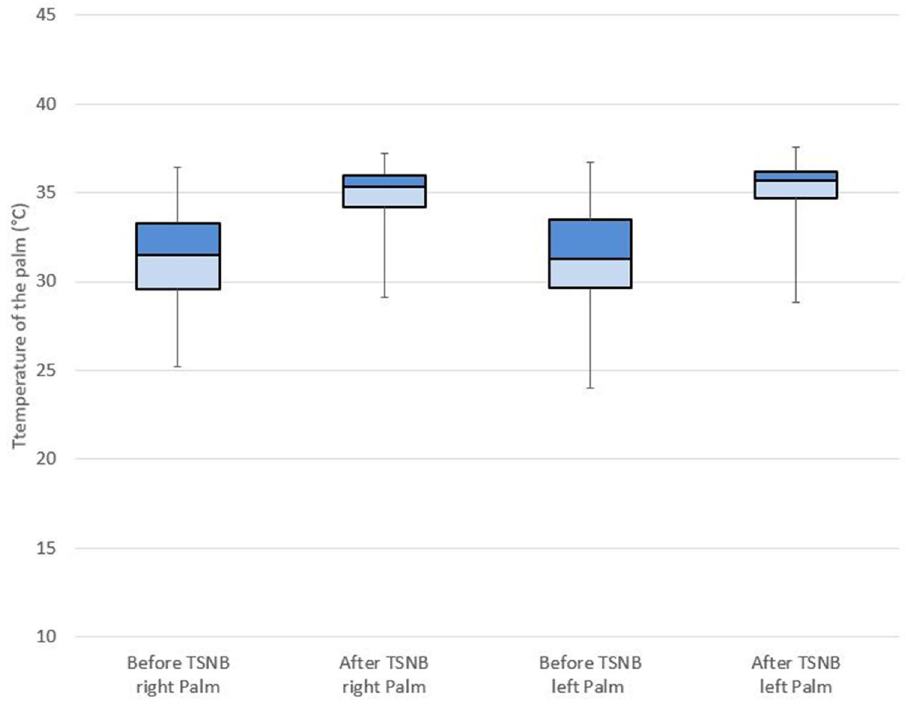
Figure 1. Box plot of the temperature of the palm before and after TSNB (thoracic sympathetic nerve block). The horizontal line indicates the median, the box is the interquartile range (IQR), and the whiskers extend to the upper adjacent value (large value = 75th percentile + 1.5 × IQR) and the lower adjacent value (smallest value = 25th percentile − 1.5 ×